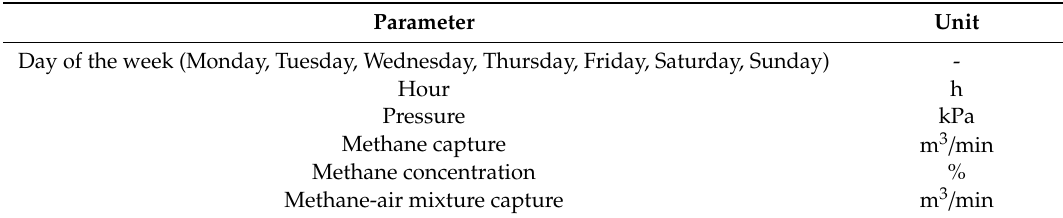
Table 4. Identified variables.